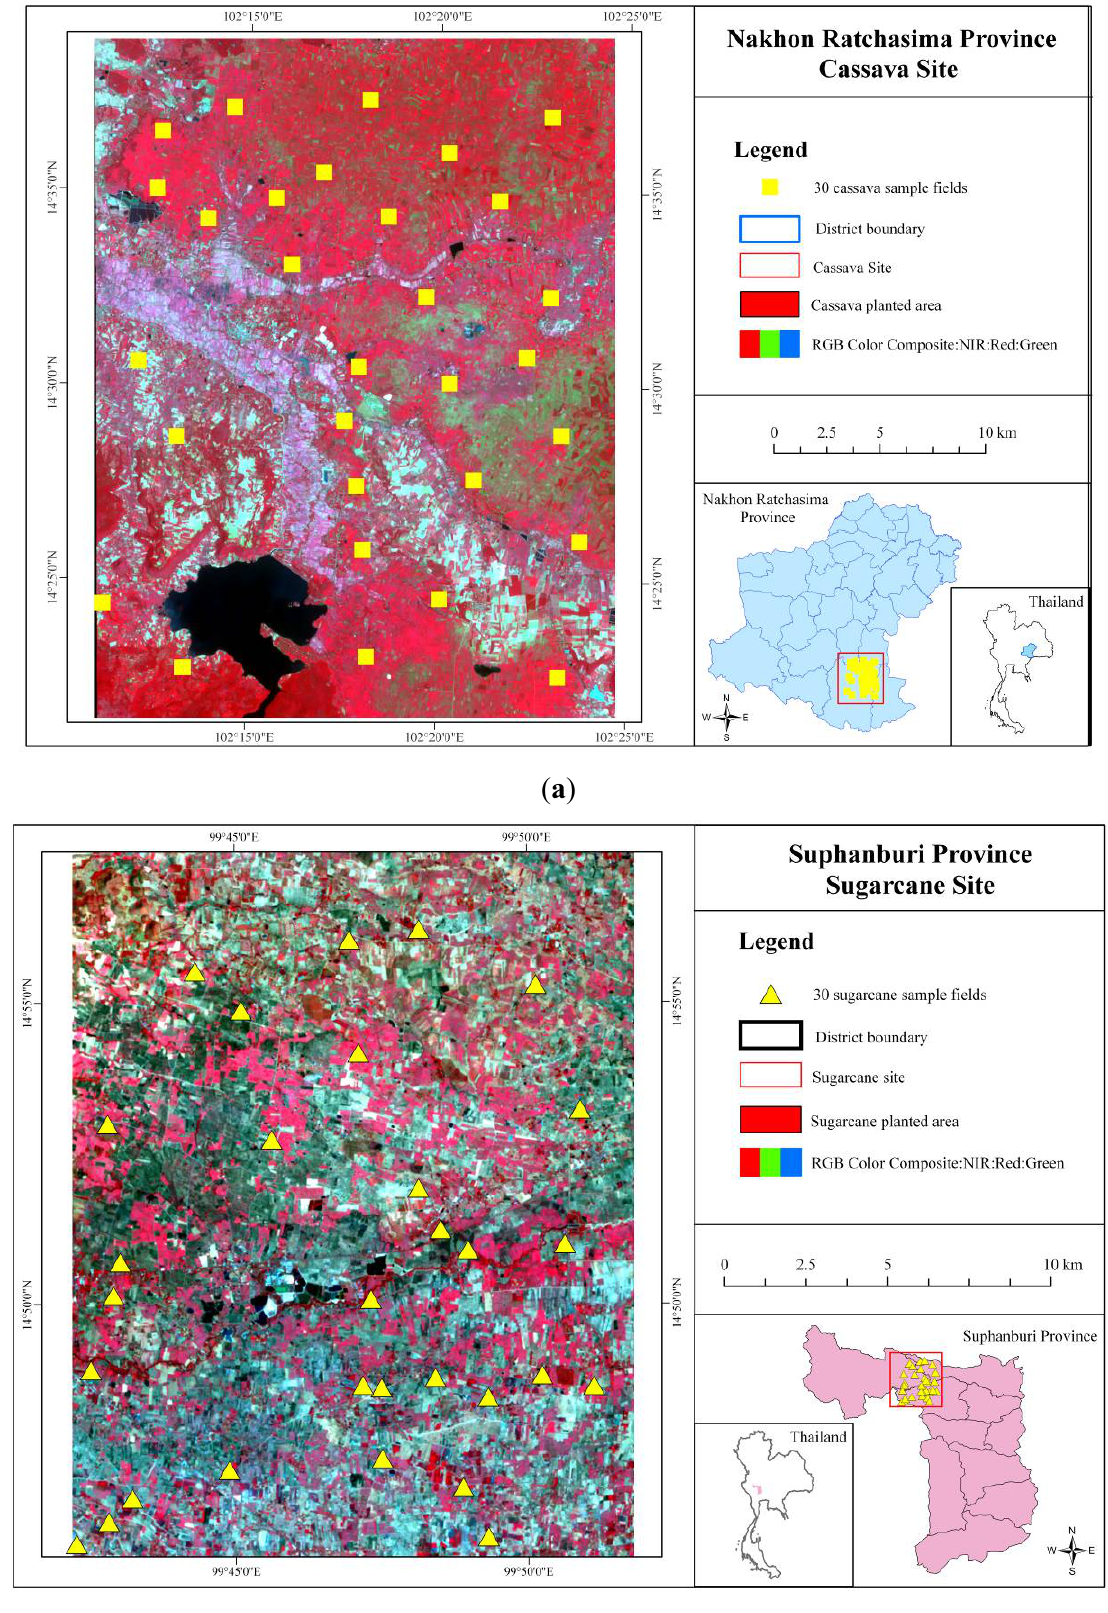
Figure 1. Study areas and locations of sample fields marked on a THEOS image. ( a ) Cassava site in Nakhon Ratchasima Province. ( b ) Sugarcane site in Suphanburi